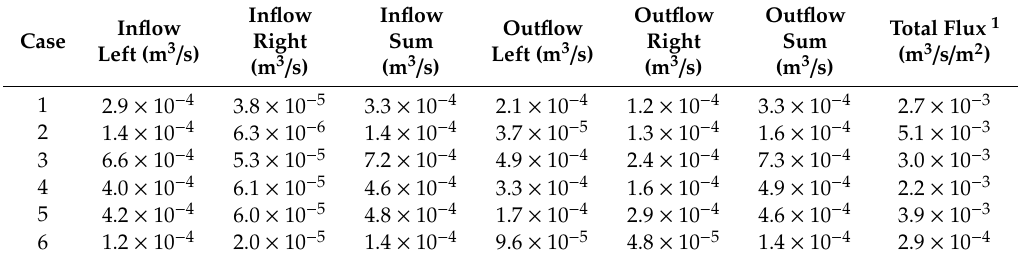
Table 2. Hyporheic fluxes of a single ripple in the center of a series of ripples for case 1–6 (sand). Right and left indicate the part of the ripple right and left of the ripple crest (compare Figure